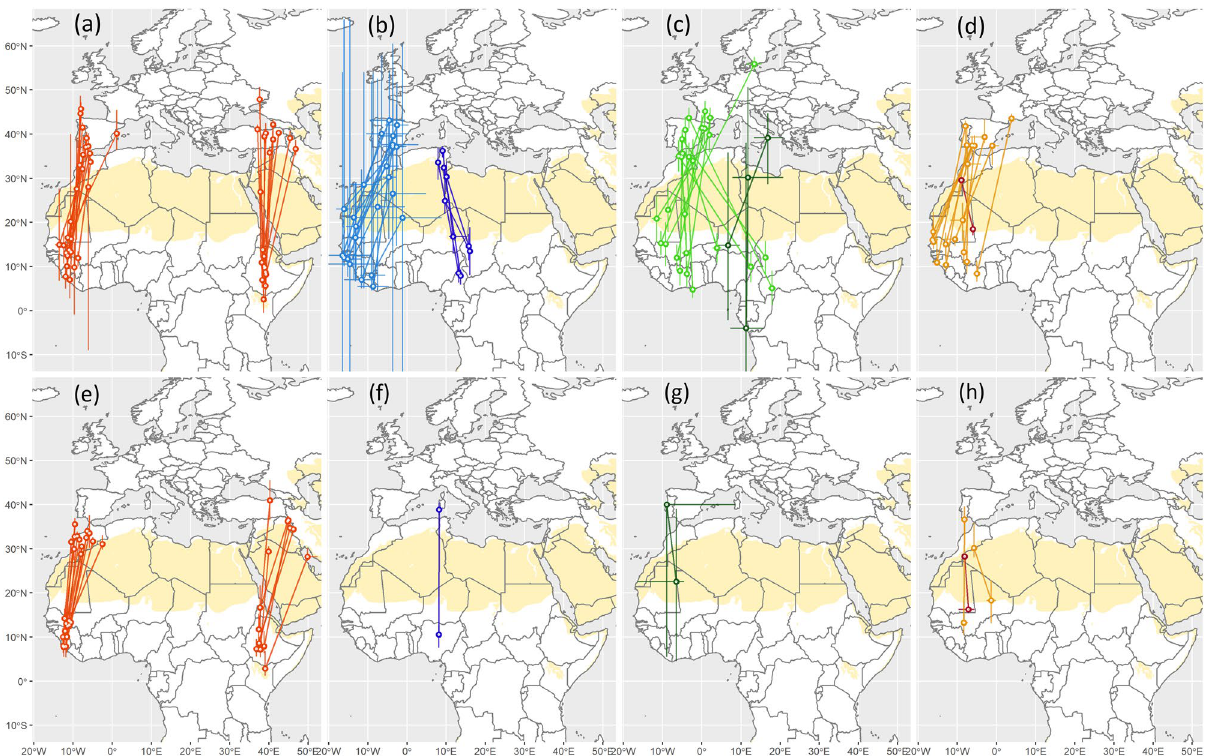
Figure 7. Stationary sites of individual birds (median ± 25th/75th or 20th/80th percentiles of location estimates) just prior and after the occurrence of the full light pattern(s) detected during autumn ( a – d ) and spring ( e – h ) migration; red = ortolan bunting ( a , e ); light blue = spotted flycatcher, dark blue = Mediterranean flycatcher (b,f); light green = willow warbler, dark green = wood warbler ( c , g ); orange = Eurasian reed warbler, dark red = rufous-tailed scrub-robin ( d , h